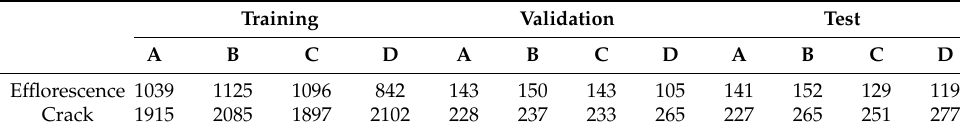
Table 3. The number of distress images in the